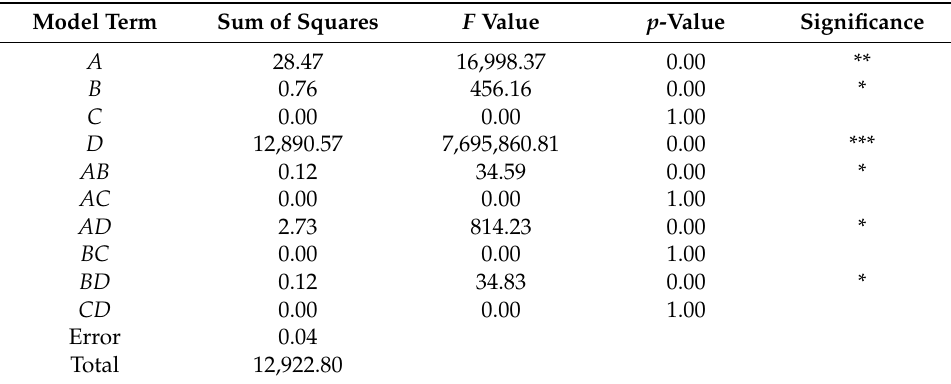
Table 3. Results of ANOVA for the runoff simulation in the non-flood period.